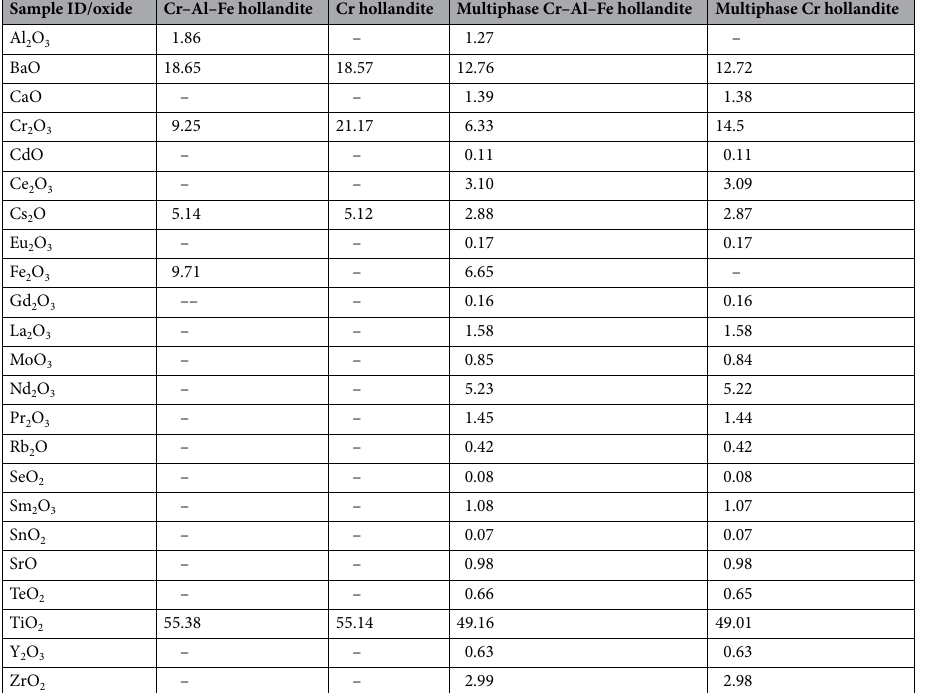
Table 1. Single-phase and multiphase simulated waste form compositions (wt %).